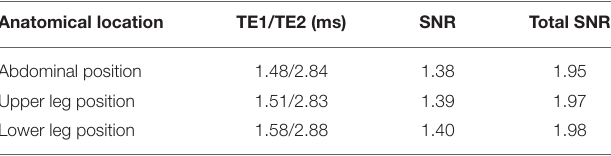
TABLE 1 | Echo times per anatomical location and respective SNR gains by the water-fat separation (SNR) and by eliminating the subtraction (Total SNR). Anatomical location TE1/TE2 (ms) SNR Abdominal position Upper leg position 1.97 Lower leg position 1.58/2.88 1.40 1.98 TE1/TE2, Echo times in millisecond; SNR, Signal-to-noise ratio by separation; Total SNR, total gain in signal-to-noise ratio compared with subtraction